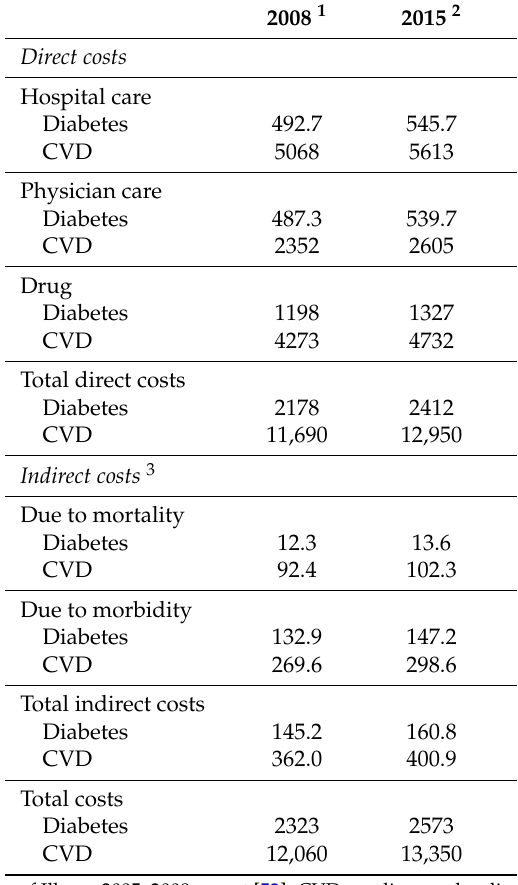
Table 2. Summary of diabetes and cardiovascular disease costs in Canada (Can$